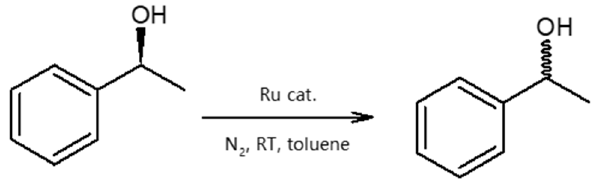
Scheme 1. Racemization of ( S